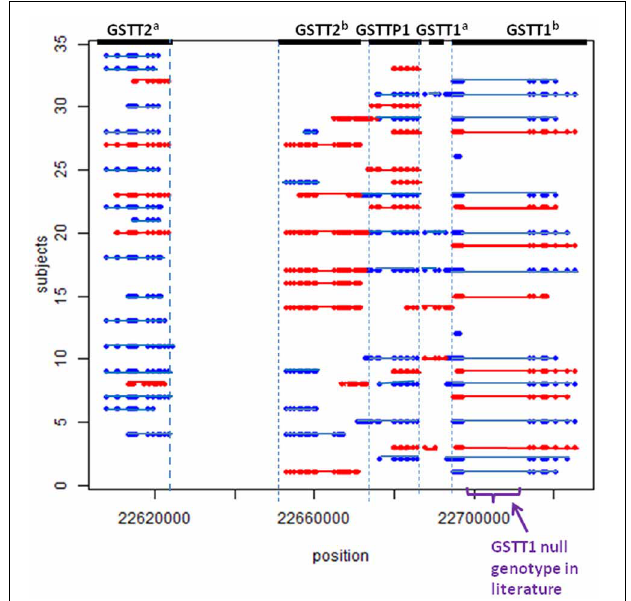
FIGURE 1 | CNV calls in a sample of 34 subjects. Each dot represents a marker. Each line represents a CNV called by PennCNV. Red is duplication, blue is deletion. No marker was located in the region of the previously-reported GSTT1 null